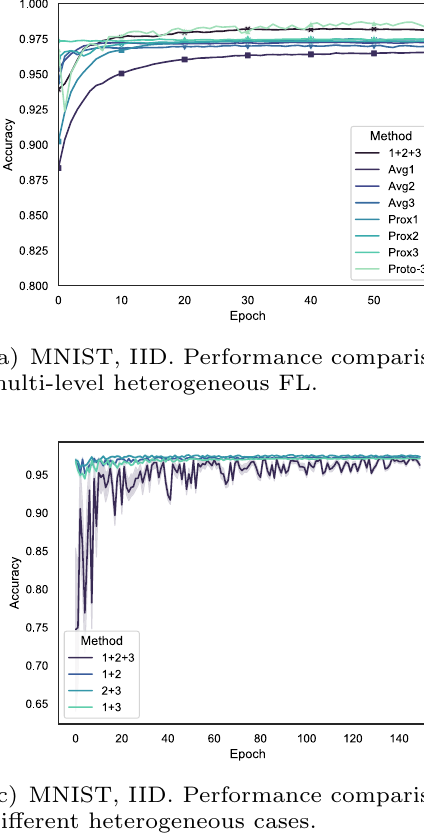
branch 2, and branch 3. There are three kinds of models with differ- ent complexities among clients in “Proto-3”, and its training method is